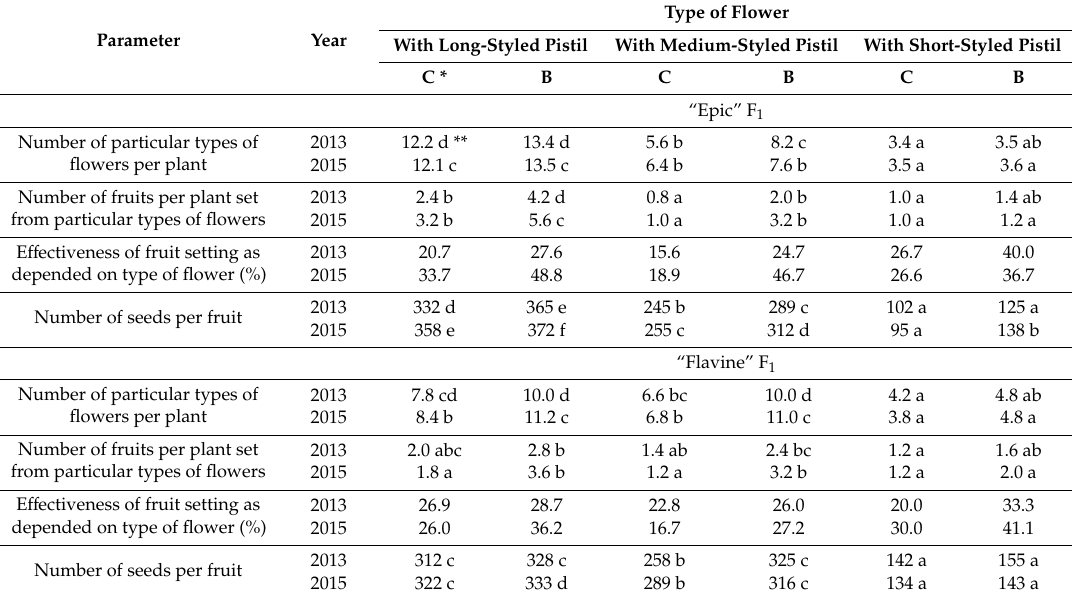
Table 2. Chosen aspects of flowering and fruit setting of eggplant as depended on fruit type and biostimulant treatment.